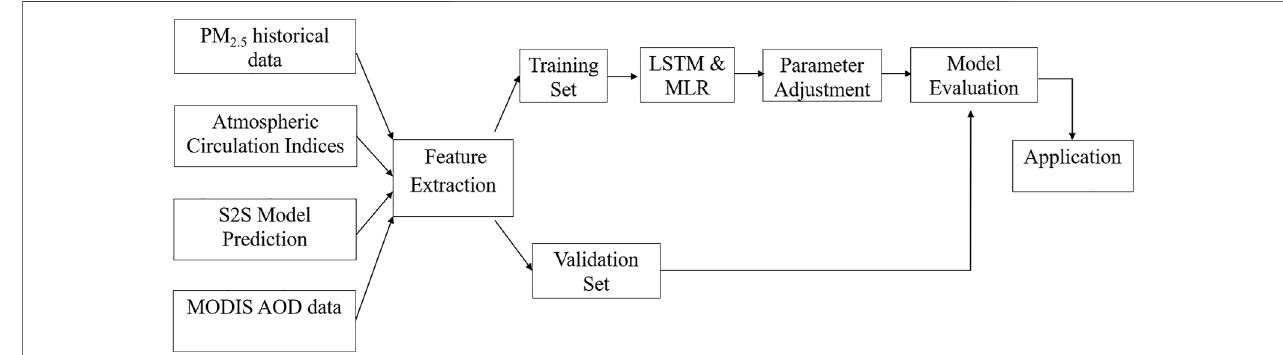
FIGURE 5 | Flowchart of the modeling